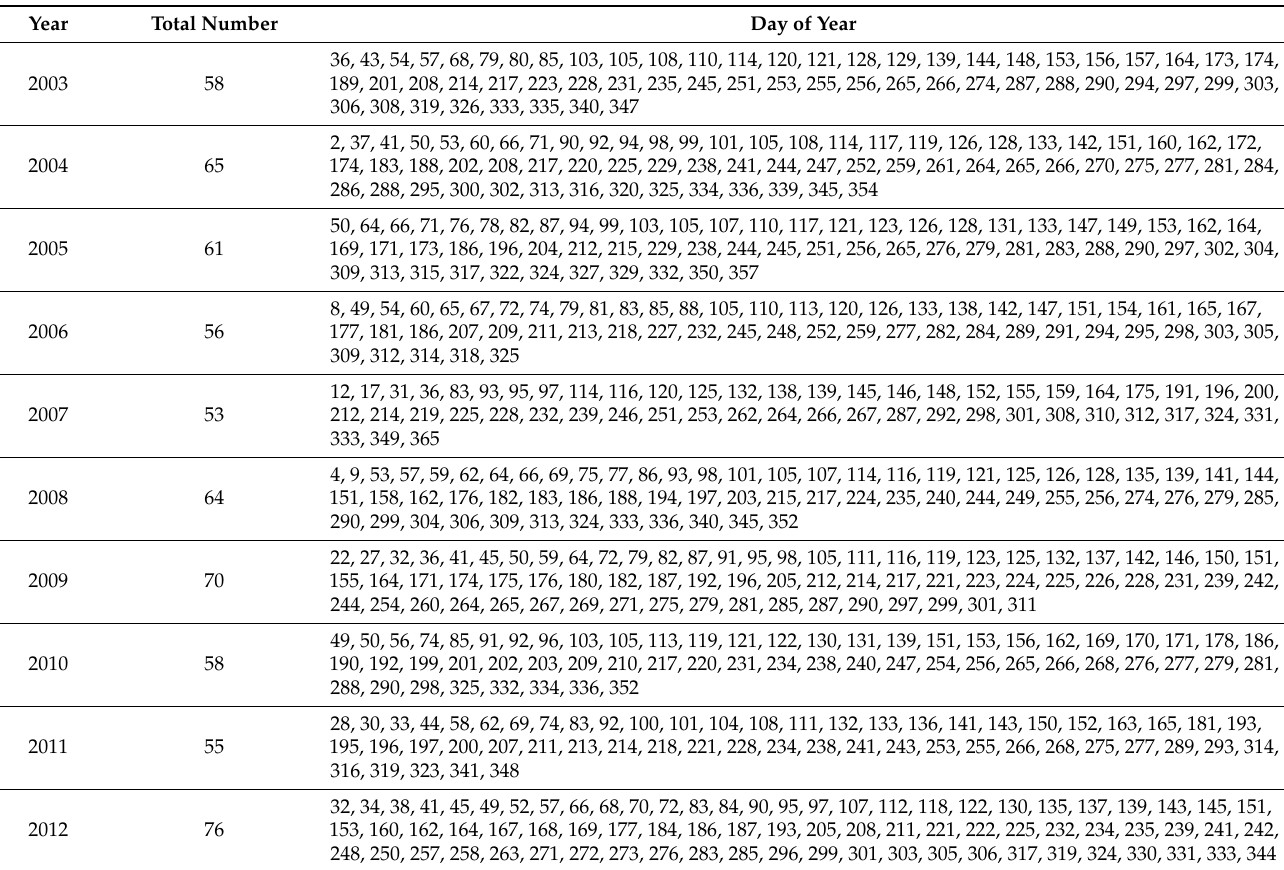
Table A1. MODIS images used in this